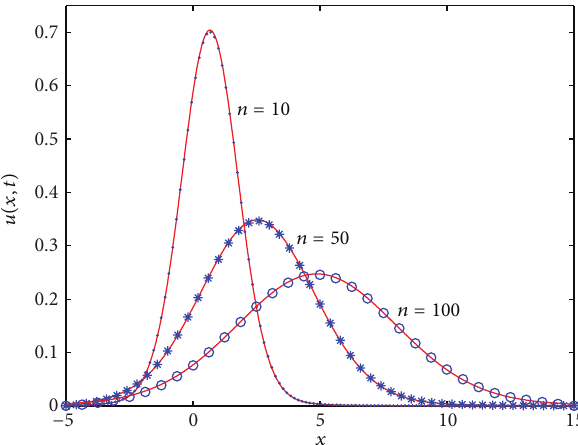
Figure 2: The same as Figure 1 but for 𝑆 = 1.3 . The errors between numerical solution and exact solution after 1000 time steps are shown by line.